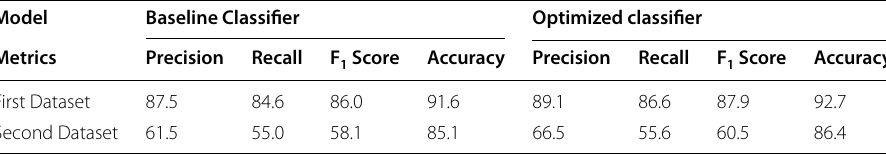
Table 6 Results for MNB classifier with the best